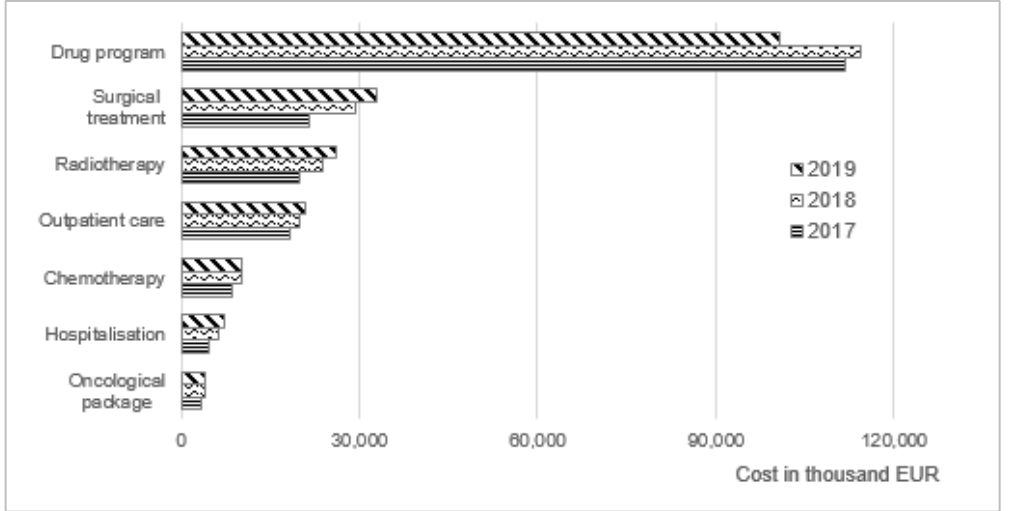
Figure 1. Total expenditures for breast cancer treatment in Poland.